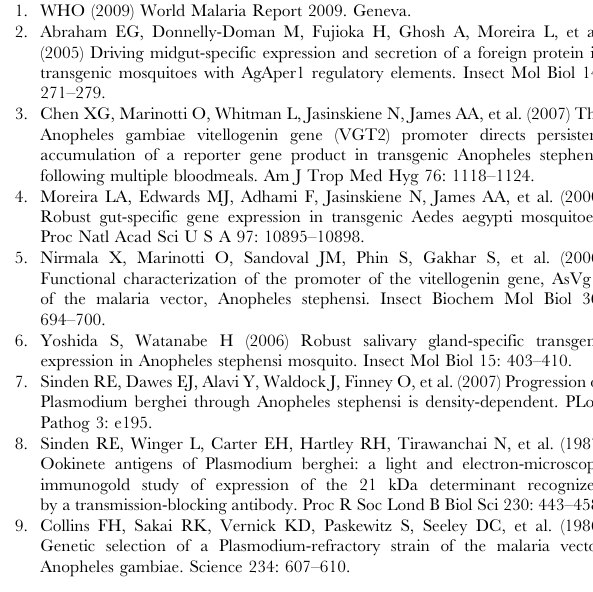
Table S1 Generation of transformants using plasmid pMinLuc. The 47 surviving adults from a total of 167 injected embryos were outcrossed with wild type A. stephensi in groups of same- sex individuals. The 24 females from the female group were allowed to lay eggs in isolation to determine the number of single founders. 4 female founders produced fluorescent individuals among their G1 progeny, indicative of a germline integration event. Transgenic progeny were interbred to achieve homozygosity of the transgene. Asterisks denote those lines that were assayed in detail for luciferase activity.